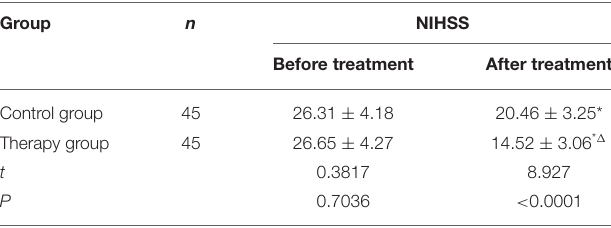
TABLE 2 | Comparison of NIHSS scores before and after treatment between the two groups (M ± S D,